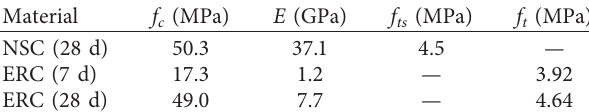
Table 1: Overview of material